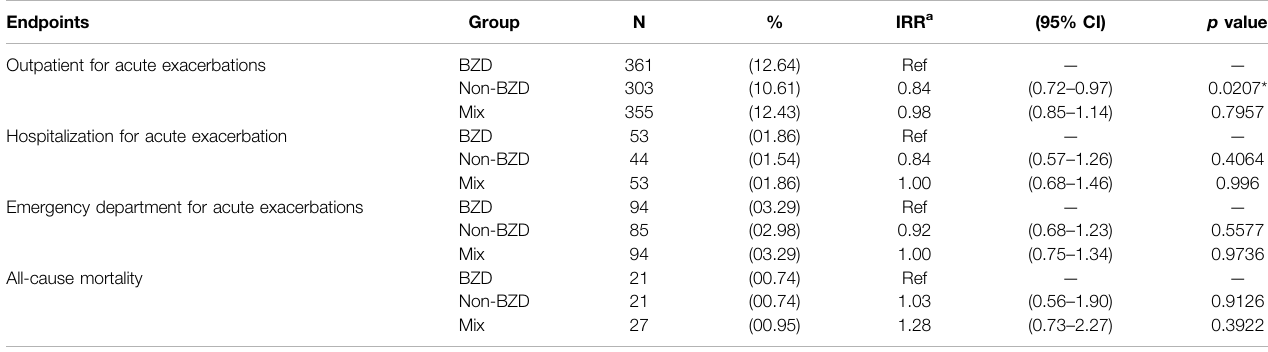
TABLE 2 | Poisson regression analysis of clinical outcomes with a matched cohort. Endpoints